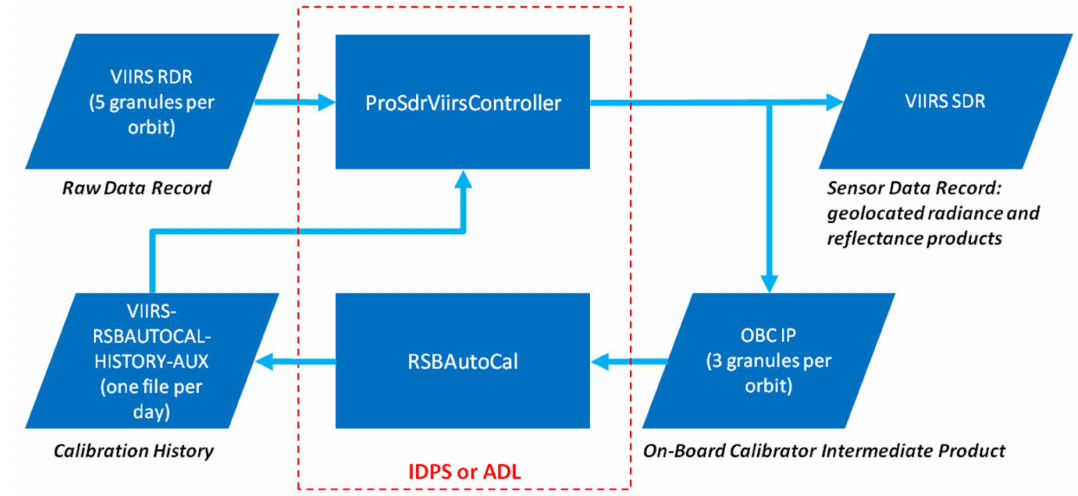
Figure 1. Flowchart of the VIIRS RSB (Reflective Solar Band) solar calibration